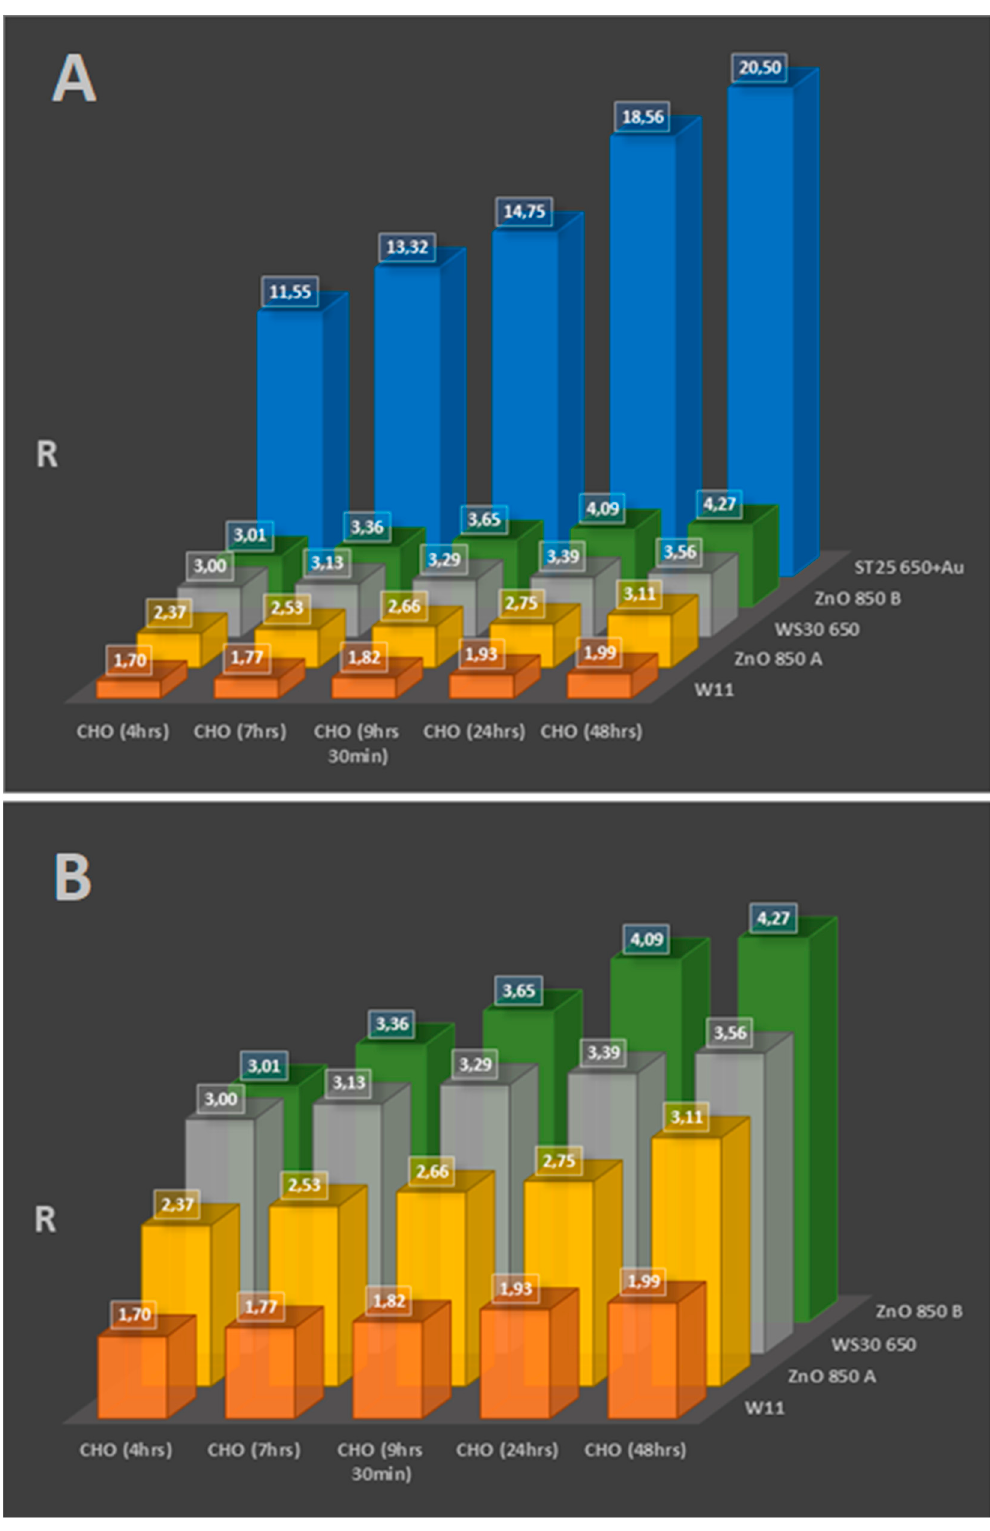
Figure 2. ( A ) Test results from ST25 650 + Au, two ZnO 850, WS30 650, and W11 sensors on Chinese hamster ovary (CHO) cell samples incubated at di ff erent times. ( B ) A zoom on the previous tests, to better appreciate which sensor responses show trends following the di ff erent concentration in the cell cultures, due to their di ff erent incubation